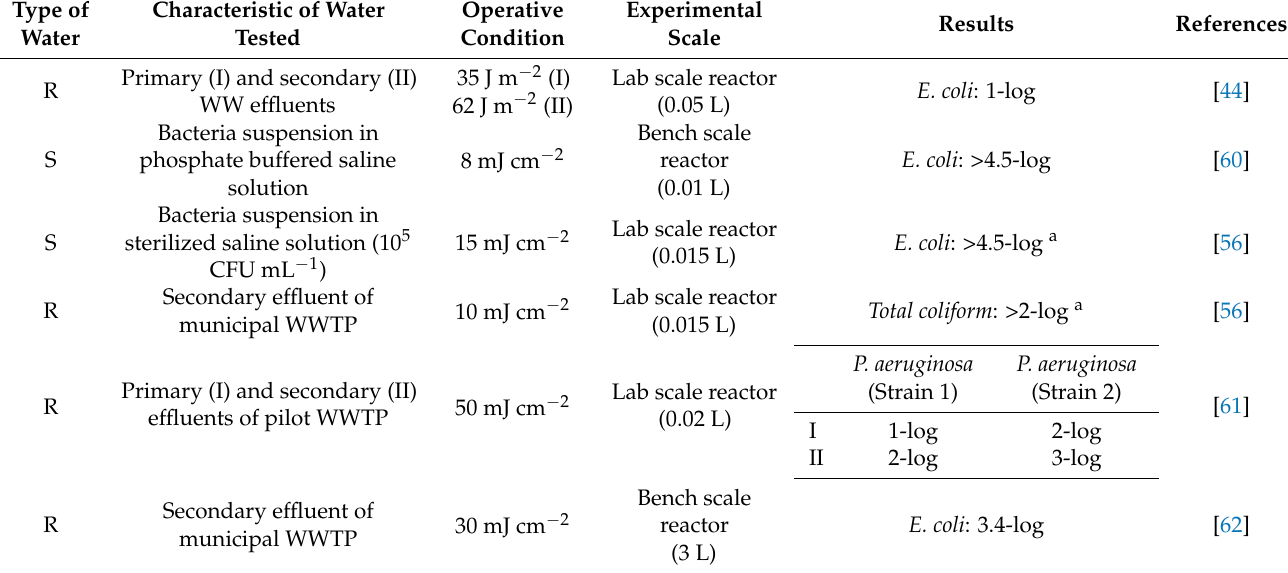
Table 1. Several results of UV disinfection tests. S: synthetic water, R: real water, WW: wastewater, WWTP: wastewater treatment